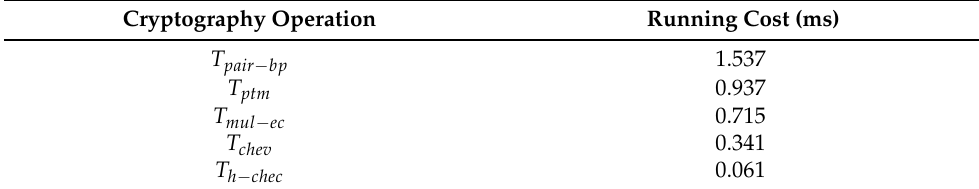
Table 1. The Running Cost of Particular Cryptography